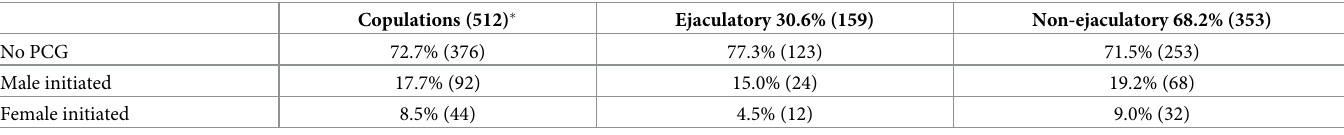
Table 5. Frequency of post-copulatory grooming (PCG) initiation in relation to copulation type (number of cases in